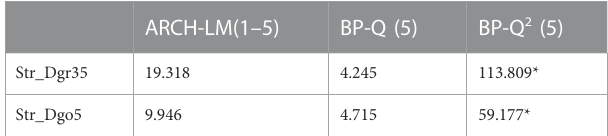
TABLE 6 Tests based on the standardised residuals of the model.